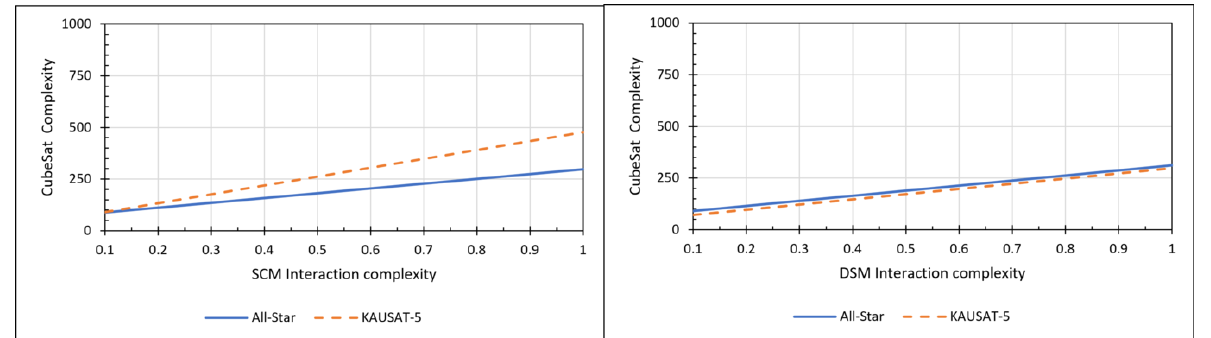
Figure 10. Impact of the interaction complexity value, β ij , to the CubeSat complexity with the SysML Complexity metric ( left ) and the DSM Complexity metric ( right